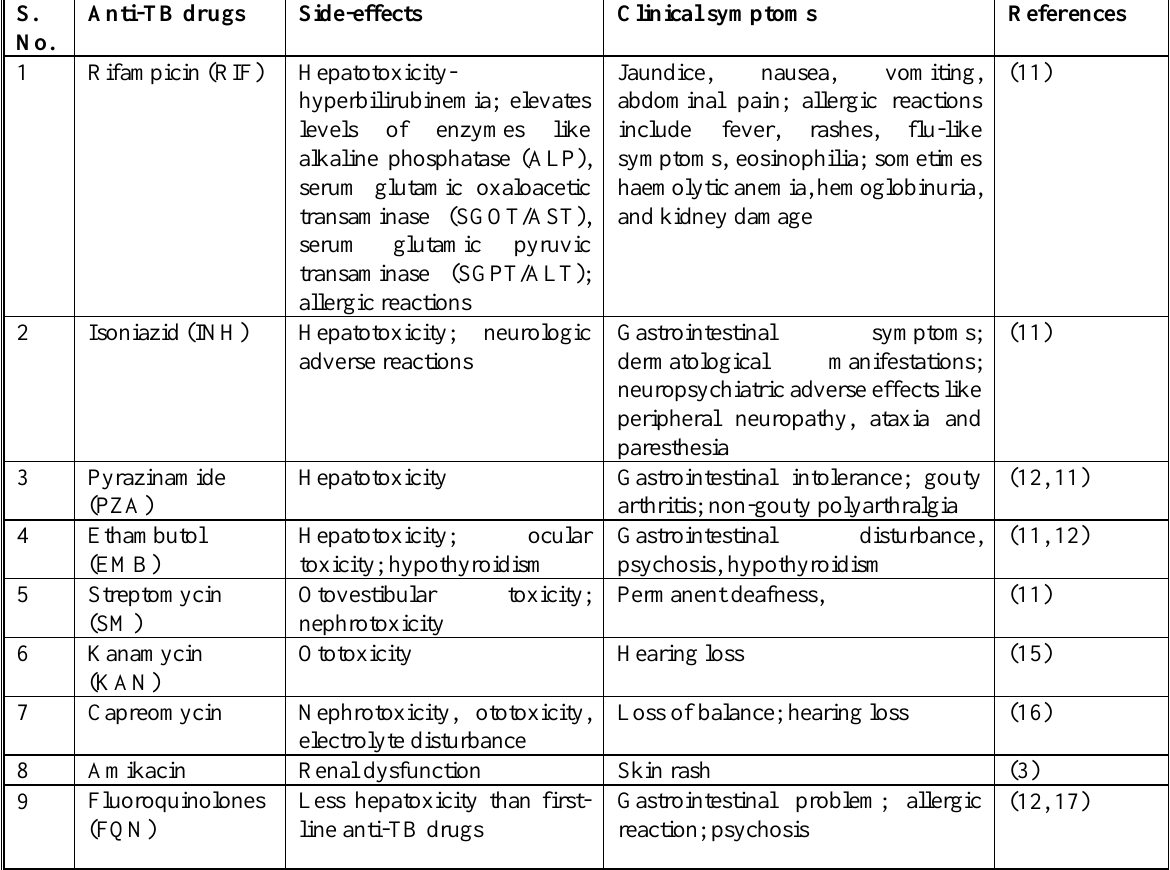
Table 1. Commonly used Anti-TB drugs and their side-effects